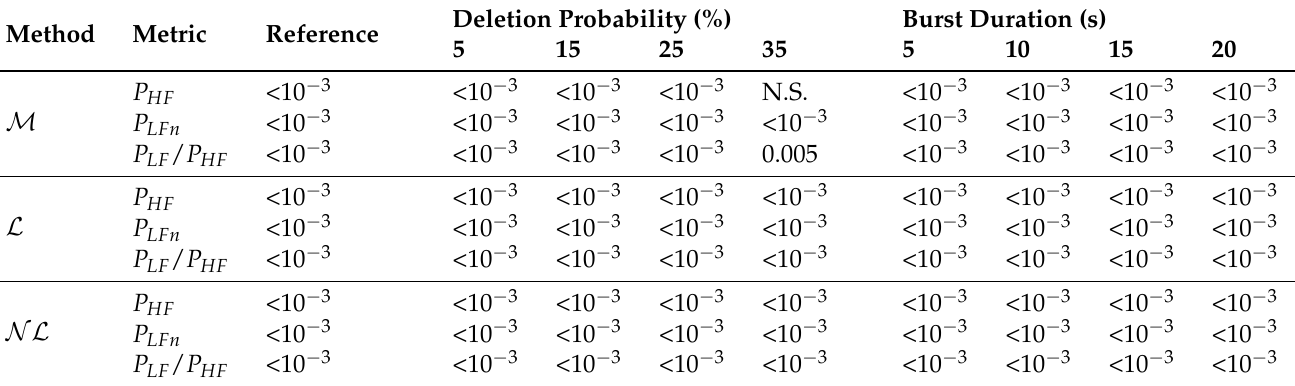
Table 5. p -values of ranked signed test for supine/tilt discrimination of frequency-domain metrics computed via FFT. N.S.: Not significant ( p >